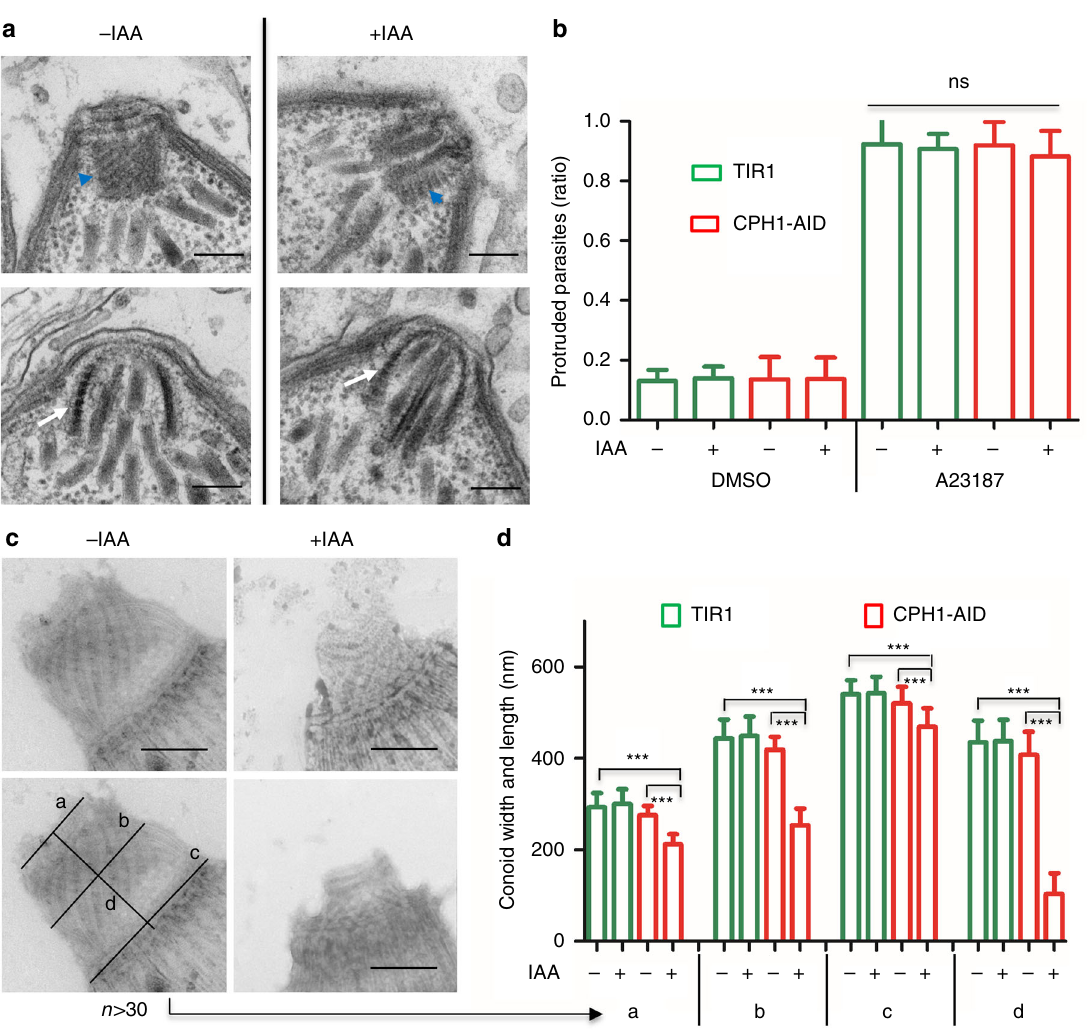
Fig. 3 CPH1 is required for conoid stability in extracellular parasites. a Conoid morphology of intracellular parasites examined by TEM. CPH1-AID parasites grown in ± IAA for 24 h. Microtubule spirals seen in tangential sections (blue arrowhead) or cross-section (white arrow). Scale bar = 200 nm. b Conoid protrusion in extracellular parasites as assessed under phase contrast microscopy. Mean ± SEM for 3 experiments with 3 replicates for each ( n = 9). DMSO served as a control. ns not signi fi cant, one-way ANOVA. c Conoid morphology of extracellular parasites examined by negative staining and TEM. Image in left bottom shows measurements for the conoid width and length (labeled as a – d ). The line with arrow points to the measurements in d . Scale bar = 250 nm. d Measurement of conoid width and length as shown in c . *** P < 0.0001, mean ± SEM ( n = 3 experiments, each with 3 technical replicates), n = 35 conoids were measured for each line ( − IAA vs. +IAA). b – d Parasites grown in ± IAA for 40 – 44 h were collected and stimulated with 3 µ M A23187